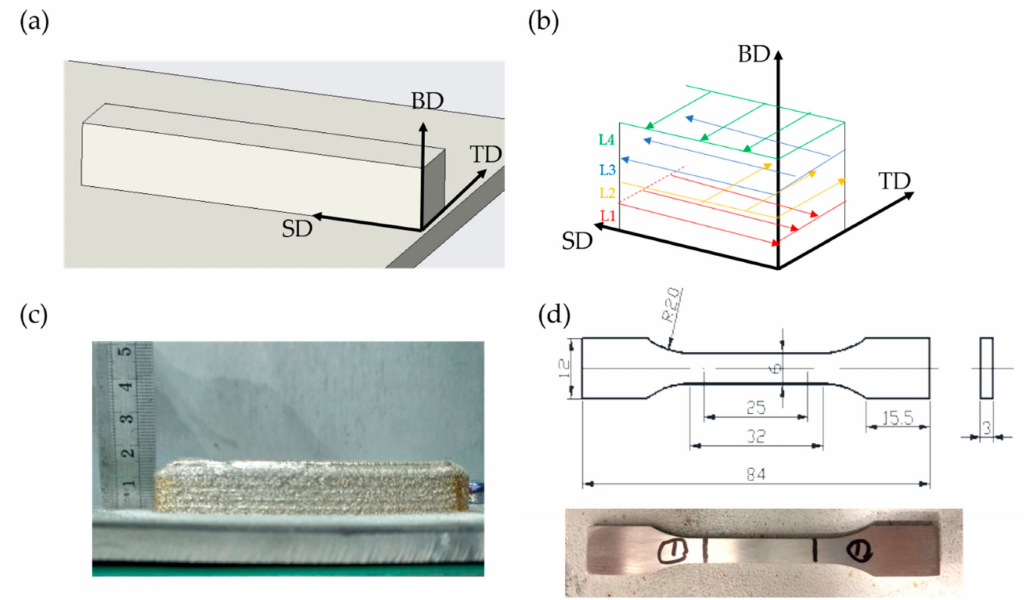
Figure 2. ( a ) The dimensional drawing of the deposited bulk; ( b ) The schematic of the scanning strategy; ( c ) The raw deposited component and ( d ) the tensile